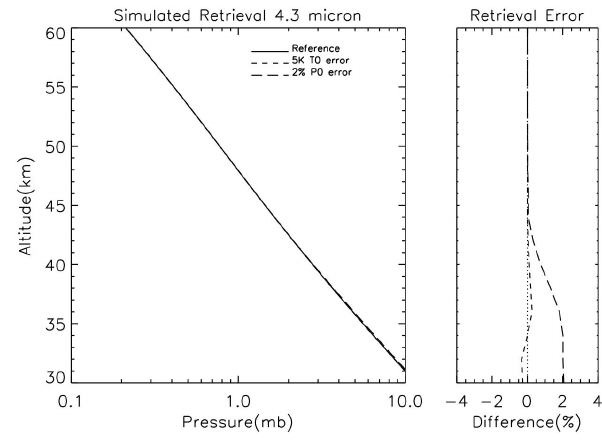
Fig. 7. Effect of lower boundary (34km) temperature and pressure errors on temperature retrieved from 4.3µm CO 2 . Solid lines are re- trievals without boundary layer error, and dashed lines are retrievals with incorrect boundary layer conditions. Right-hand panel shows the errors.